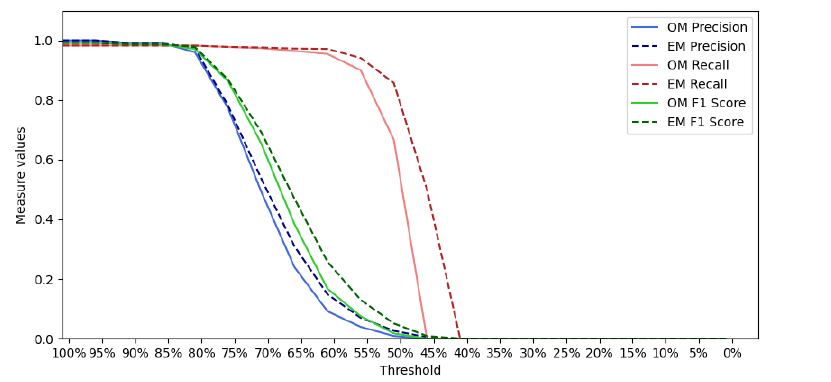
Figure 13. Results of the event “Prince Toronto”.